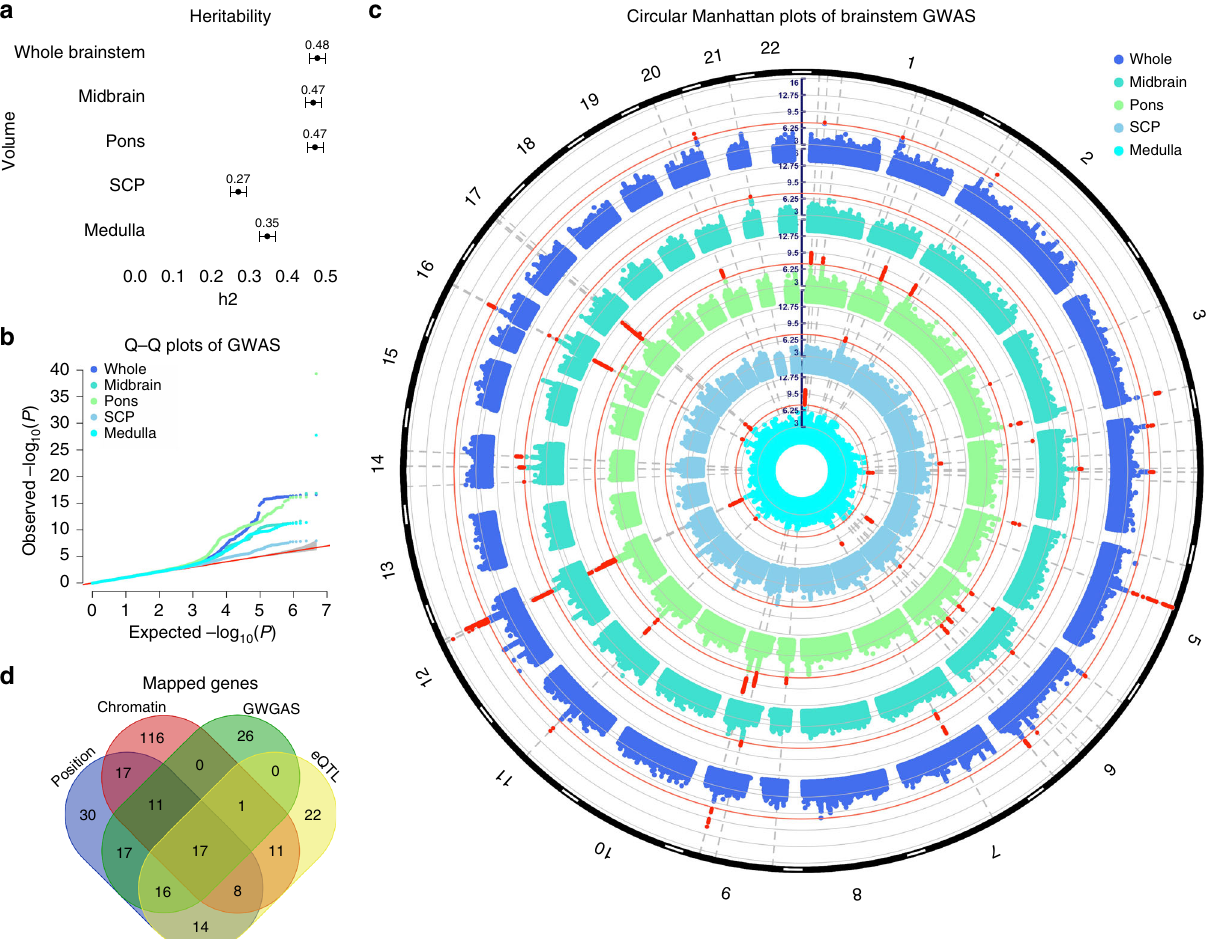
Fig. 1 Analysis of GWAS discovery sample identi fi es 61 loci associated with brainstem volumes. a GCTA-based heritability estimates for the brainstem volumes in the discovery sample of n = 27,034 participants from the UK Biobank. All brainstem volumes showed substantial heritability, with higher estimates for the whole brainstem ( h 2 = 0.48), midbrain ( h 2 = 0.47), and pons ( h 2 = 0.47) and lower for the medulla oblongata ( h 2 = 0.35) and SCP ( h 2 = 0.27). Error bars, s.e. b Q − Q plots for the brainstem volumes of the discovery sample. c Circular Manhattan plots of GWAS for brainstem volumes of the discovery sample. The outermost plot in blue re fl ects the GWAS of whole brainstem volume, whereas, from the periphery to center, the turquoise, green, gray/blue, and cyan plots indicate the GWAS of the midbrain, pons, SCP, and medulla oblongata volumes, respectively. Red circular lines indicate genome- wide signi fi cance and the red radial lines are signi fi cant loci (two-sided P < 5e − 8). d Venn diagram showing number of genes mapped by the four different strategies in the discovery sample, i.e., positional gene (blue), expression quantitative trait loci (eQTL; yellow), and chromatin interaction mapping (red), and identi fi cation by the GWGAS (green). Seventeen genes were identi fi ed by all four approaches. Whole whole brainstem. SCP superior cerebellar peduncle. Medulla medulla oblongata. GW(G)AS genome-wide (gene-based) association analyses. GCTA genome-wide complex trait